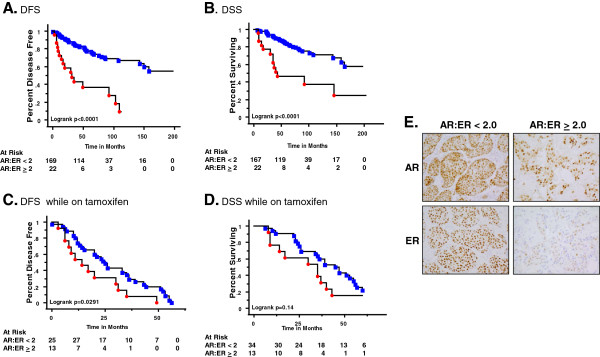
Women with tumors having a higher AR:ER ratio have a shorter disease-free and disease-specific overall survival as compared with patients with lower AR:ER ratio. Immunohistochemistry for androgen receptor (AR) and estrogen receptor (ER) were performed on formalin-fixed paraffin-embedded sections of primary breast cancers. Slides were scored for the percent of positive nuclear staining for AR and ER. Ratios were calculated to determine the best cutoff point for analysis. For (A) to (D) women are divided into two groups: those with AR:ER ratios <2.0 (blue squares) and those with AR:ER ratios ≥2.0 (red circles). The number of patients at risk at each time point is reflective of the number of patients censored due to no further follow-up data at each time point (underneath). Kaplan–Meier survival curve for: (A) disease-free survival (DFS) for all patients; (B) disease-specific survival (DSS) overall for all patients; (C) DFS for patients who failed while on tamoxifen therapy; (D) DSS overall for patients who failed while on tamoxifen therapy; and (E) representative images of AR and ER staining from the two groups (400× magnification).